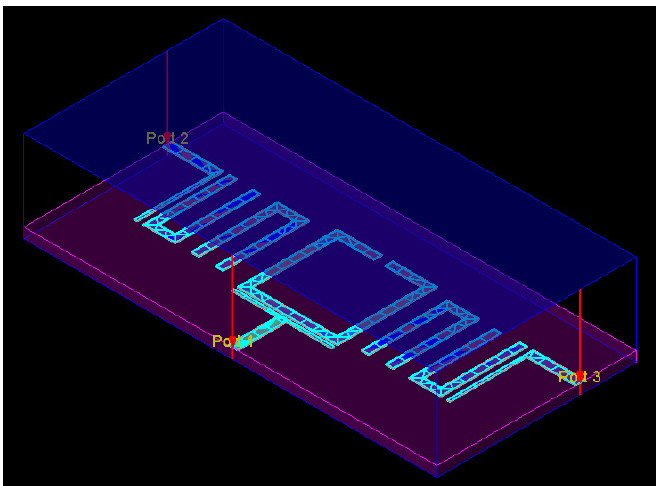
Figure 8. Three-dimensional momentum visualization of the proposed unbalanced filtering power splitter with visible mesh and current distribution at 2.6 GHz.